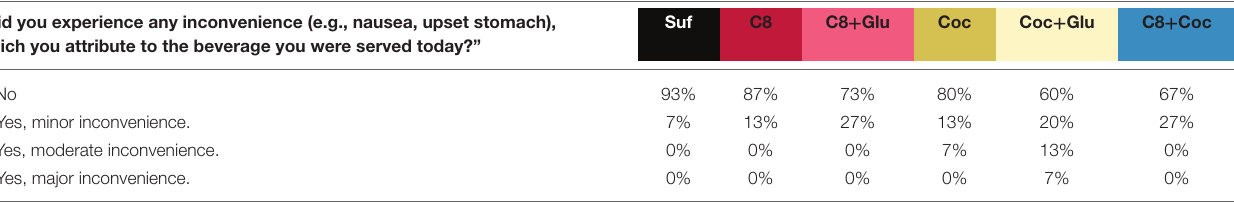
Arm 1: Black was selected to represent the “control” arm. Arm 2 and 4: Red and sand were arbitrarily chosen colors for C8 and Coc. Arm 3 and 5: These arms correspond to 2 and 4, respectively (with glucose added). Colors are therefore the same as 2 and 4, but with lower opacity (in Figures 2 , 5 they are striped, instead of changing opacity). Arm 6: Blue was chosen arbitrarily as a contrasting